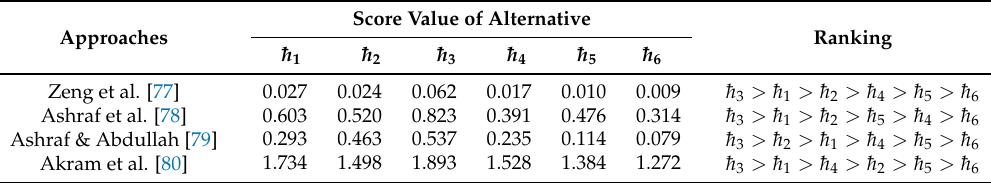
Table 13. Comparison